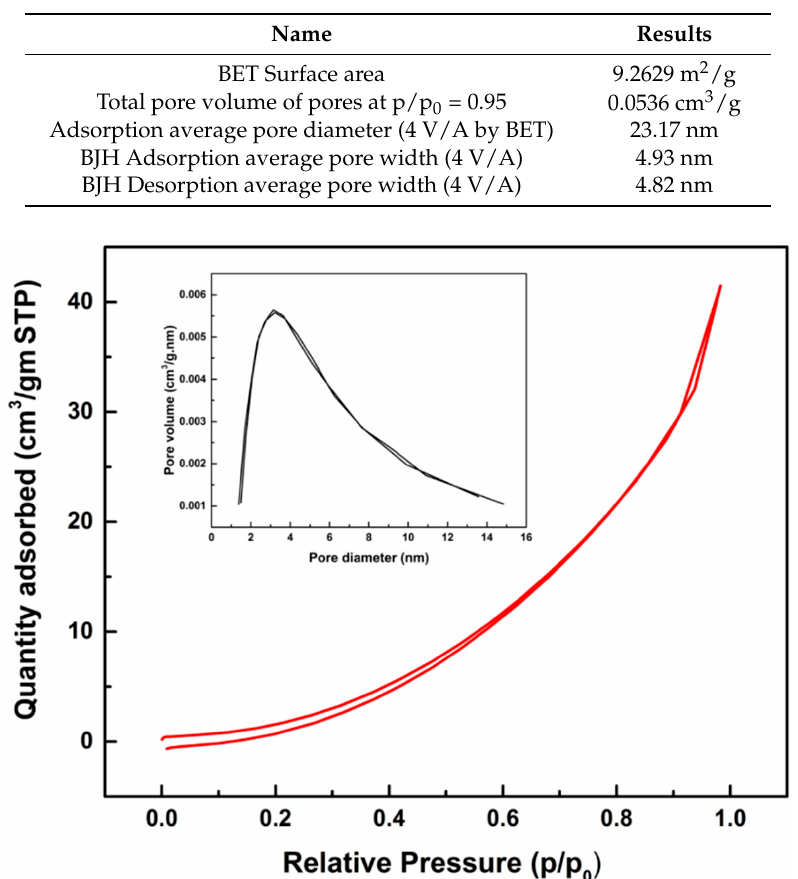
Table 3. Surface area analysis of synthesized ZnO nanoparticles.